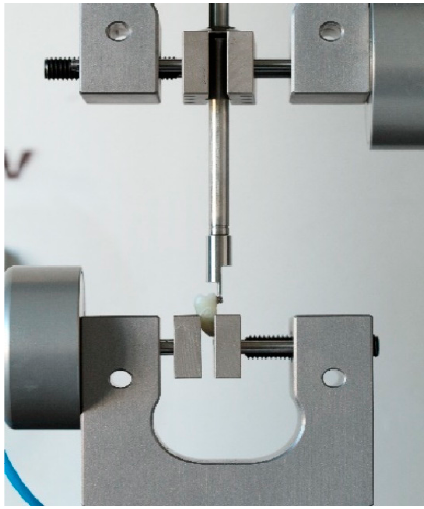
Figure 5. Setup for the test.